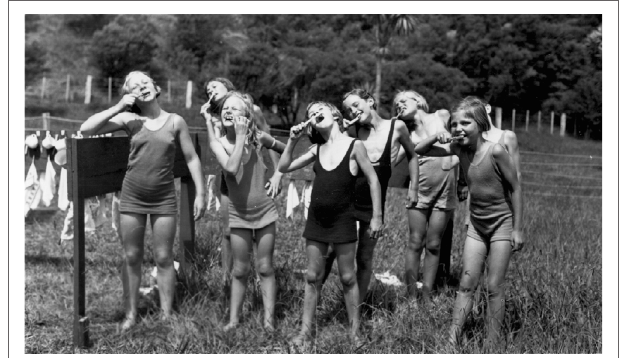
FiguRe 2 | Toothbrush drill at a Health Camp [Hocken Collections, Uare Taoka o Ha¯kena, University of Otago Library (Archives Reference: